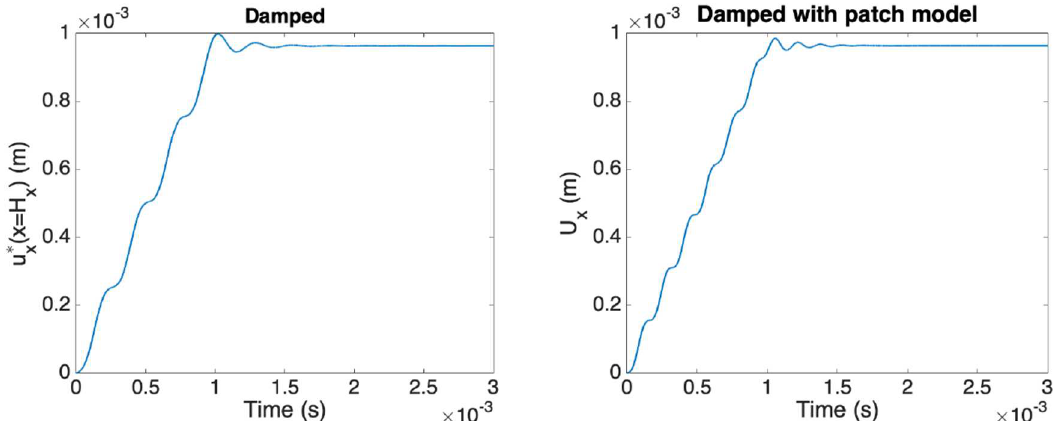
Fig. 16. Damped explicit integrations: (left) the one related to the solution in the whole domain and already depicted in Figure 11 (right); (right) the one related to the global-local integration just depicted in Figure 15